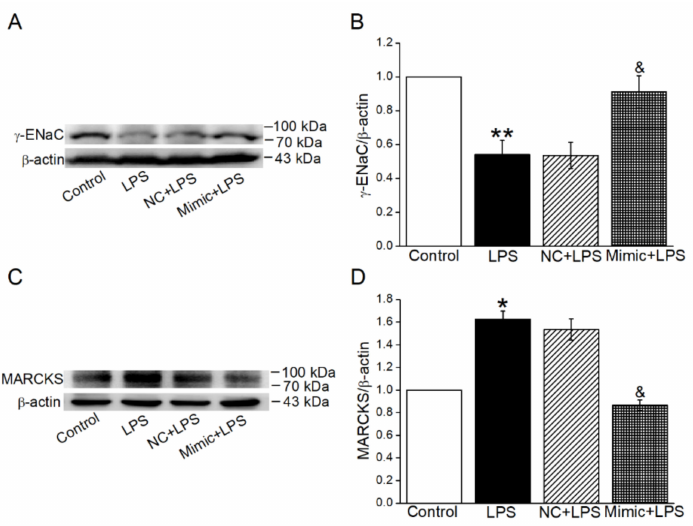
Figure 8. MiR-34c could enhance γ -ENaC expression and inhibit the MARCKS expression in ALI mouse model. ( A , C ) Representative blots of γ -ENaC and MARCKS protein in Control, LPS, NC + LPS and Mimic + LPS group in ALI mouse model, respectively. ( B , D ) Graphical representation of data obtained from Western blot and quantified through gray analysis ( γ -ENaC/ β -actin and MARCKS/ β - actin) ( n = 4). Note: * p < 0.05, ** p < 0.01, compared with Control group; & p < 0.05, compared with NC + LPS